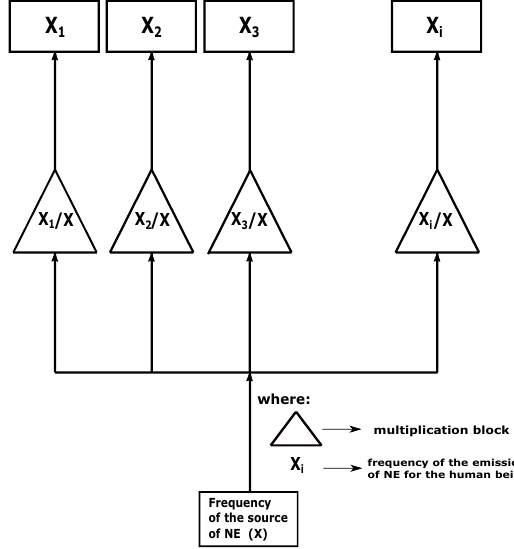
Figure 1. Generation of the personalized life frequency.